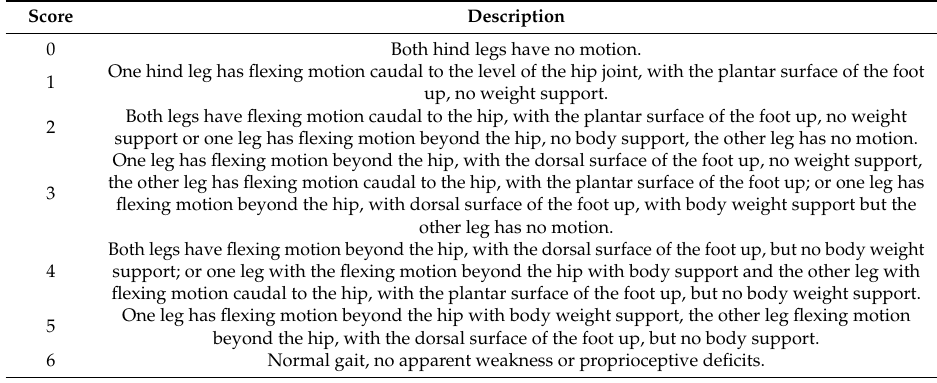
Table 2. Hind end (HE) motor function score standard.